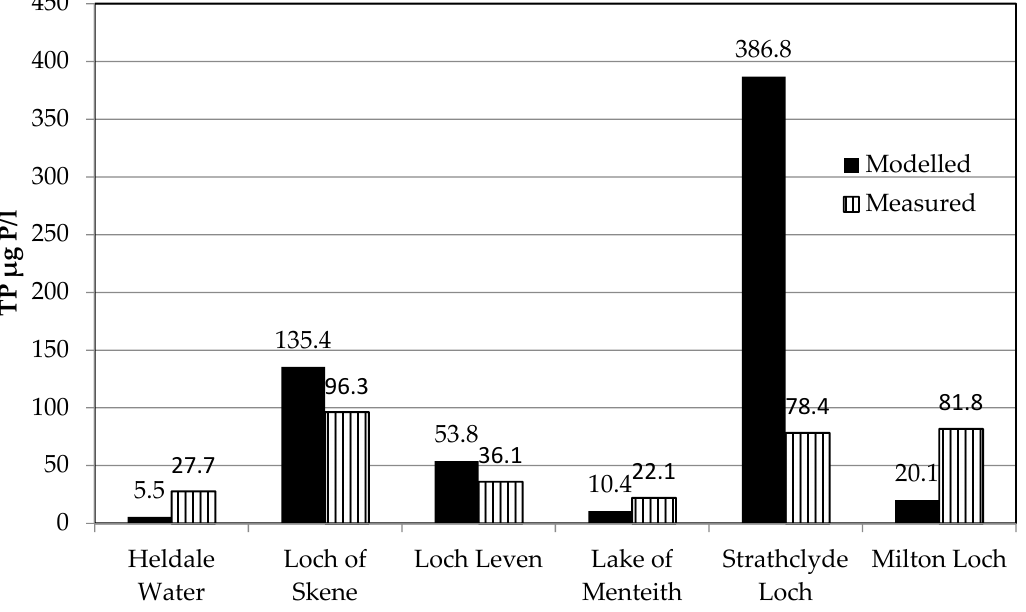
Figure 8. Comparison of measured and modelled P concentration in the selected case study catchments.